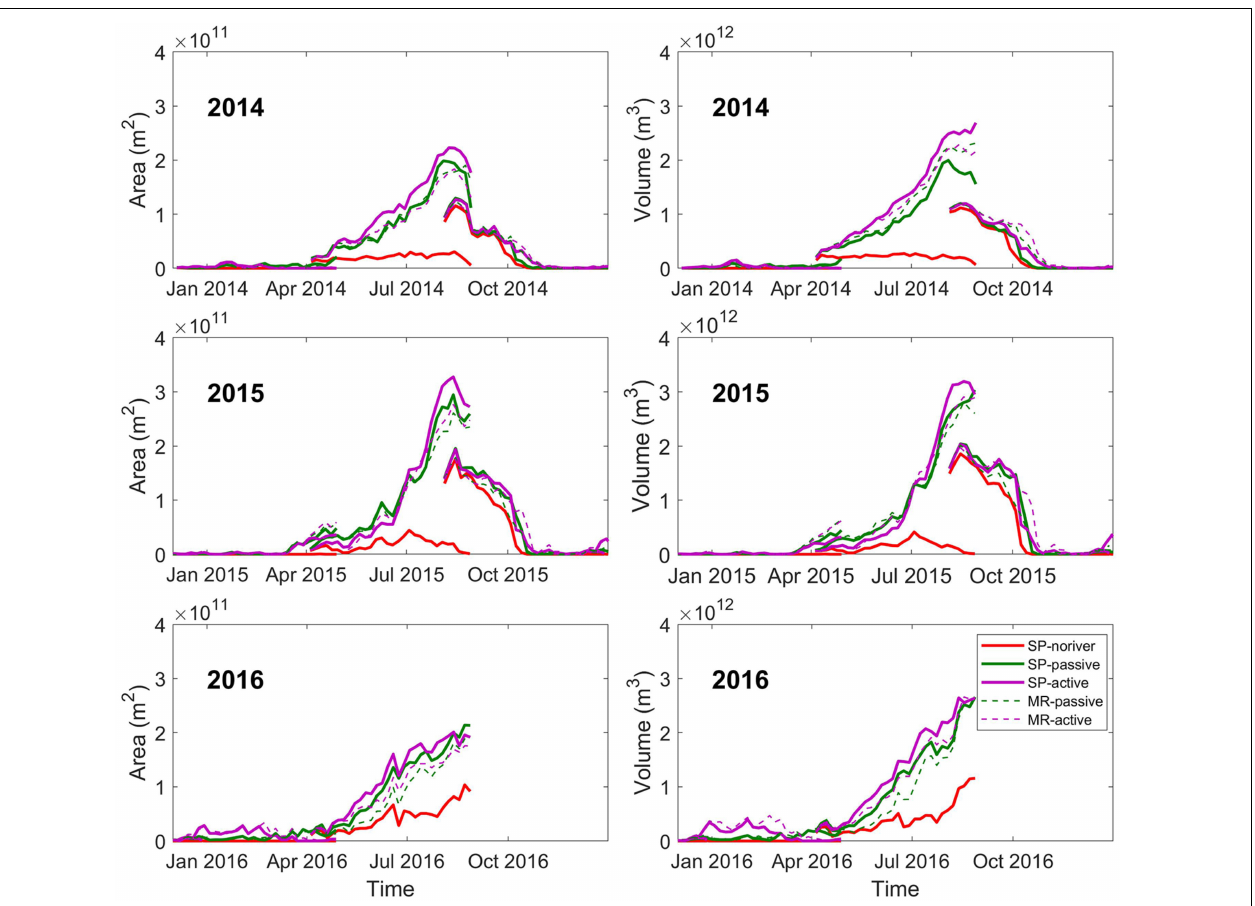
FIGURE 5 | Time evolution of the ensemble mean area (left) and volume (right) of freshwater (psu < 34) in 2014, 2015, and 2016 in waters with depth greater than 100 m. The standard deviation is always much less than one order of magnitude of the mean value and is not shown for